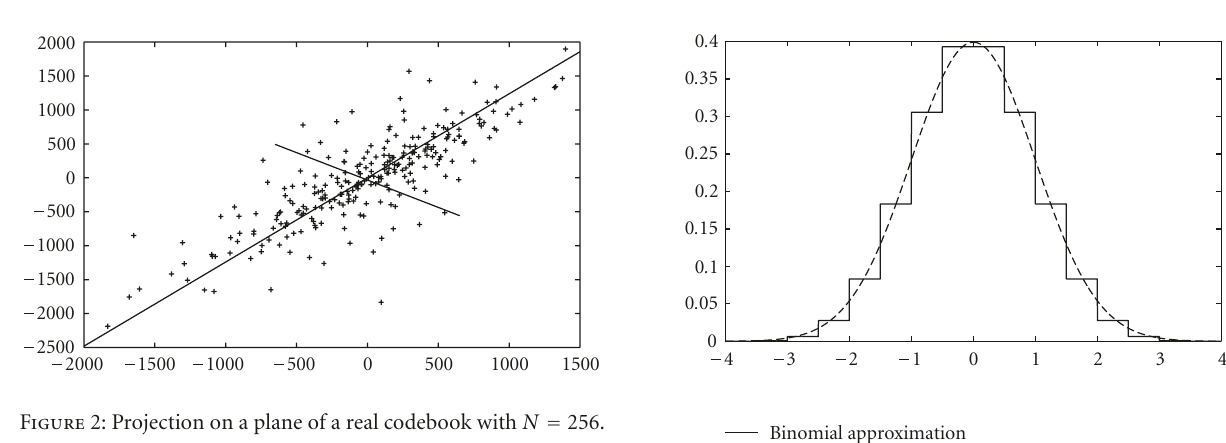
Figure 2: Projection on a plane of a real codebook with N = 256.